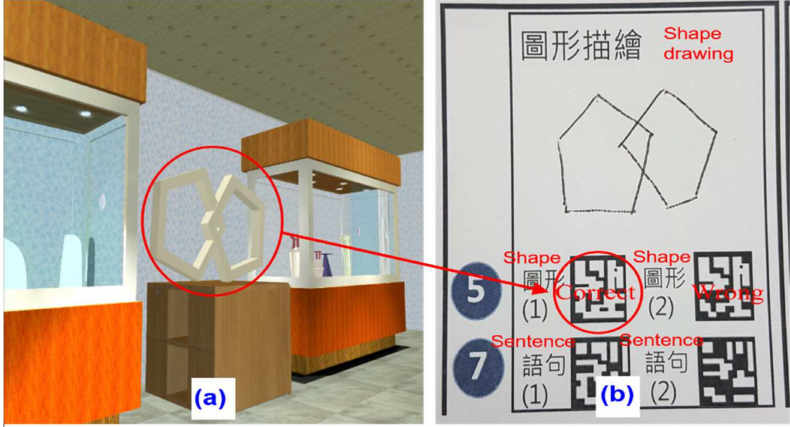
Figure 6. Vision and processing test screen: ( a ) A specific pattern needs to be identified; ( b ) A specific shape needs to be drawn on the cognitive board. If correct, scan the “no. 1” code with a mobile phone.